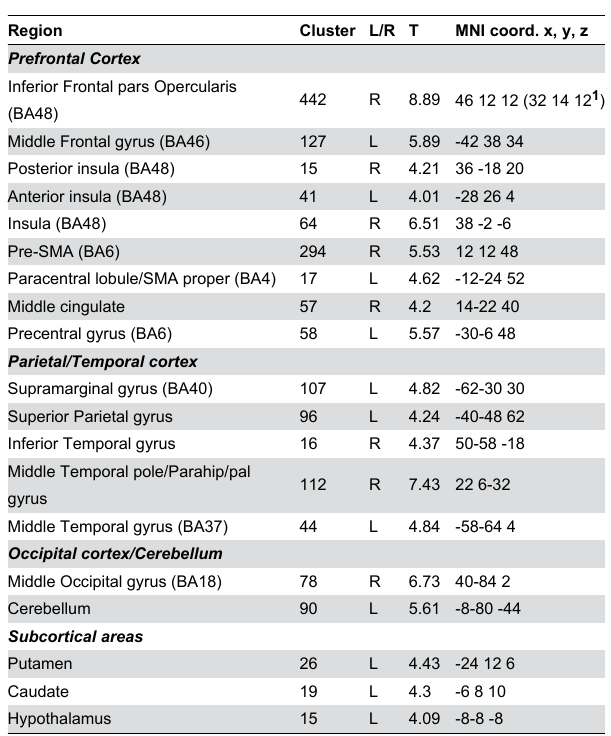
Table 3. Indices of performance in the VSST (at baseline and during scanning) and VSST_C, presented separately for the placebo, the 0.4g/kg, and the 0.8g/kg alcohol-dose groups.